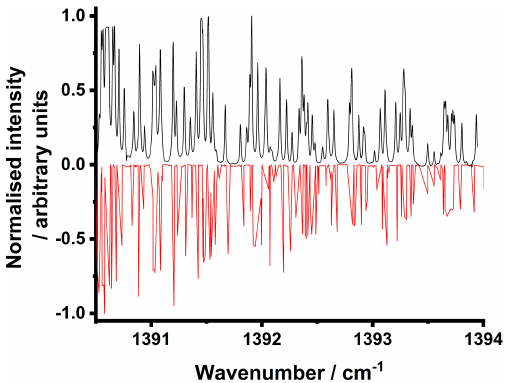
Figure 2. Normalised observed spectrum (black) for SO 2 with the corresponding normalised spectrum reported on the HITRAN database (Gordon et al., 2017; Kochanov et al., 2019) (multiplied by − 1) (red). HITRAN data are given as line intensities and thus do not account for any line broadening.